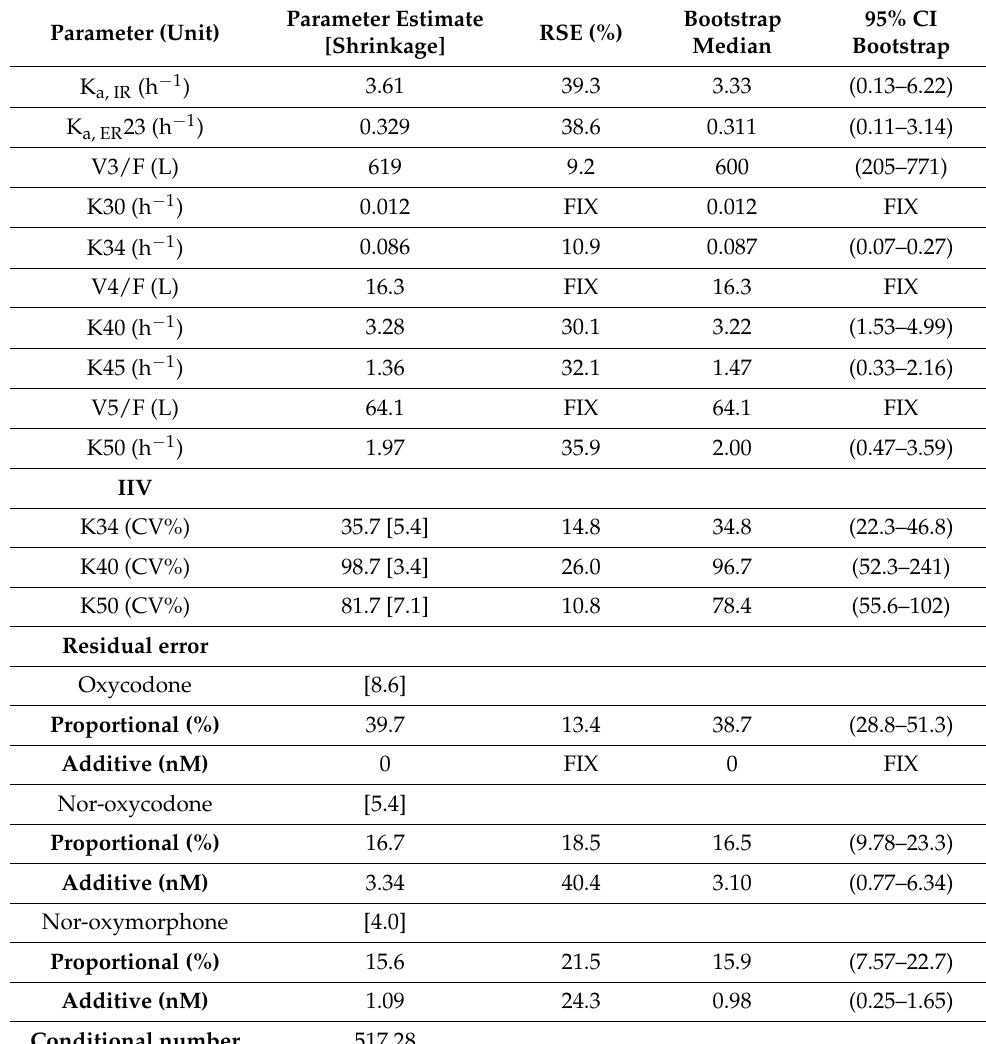
Table 2. Parameter estimations and bootstrap results of the joint oxycodone, nor-oxycodone and nor-oxymorphone